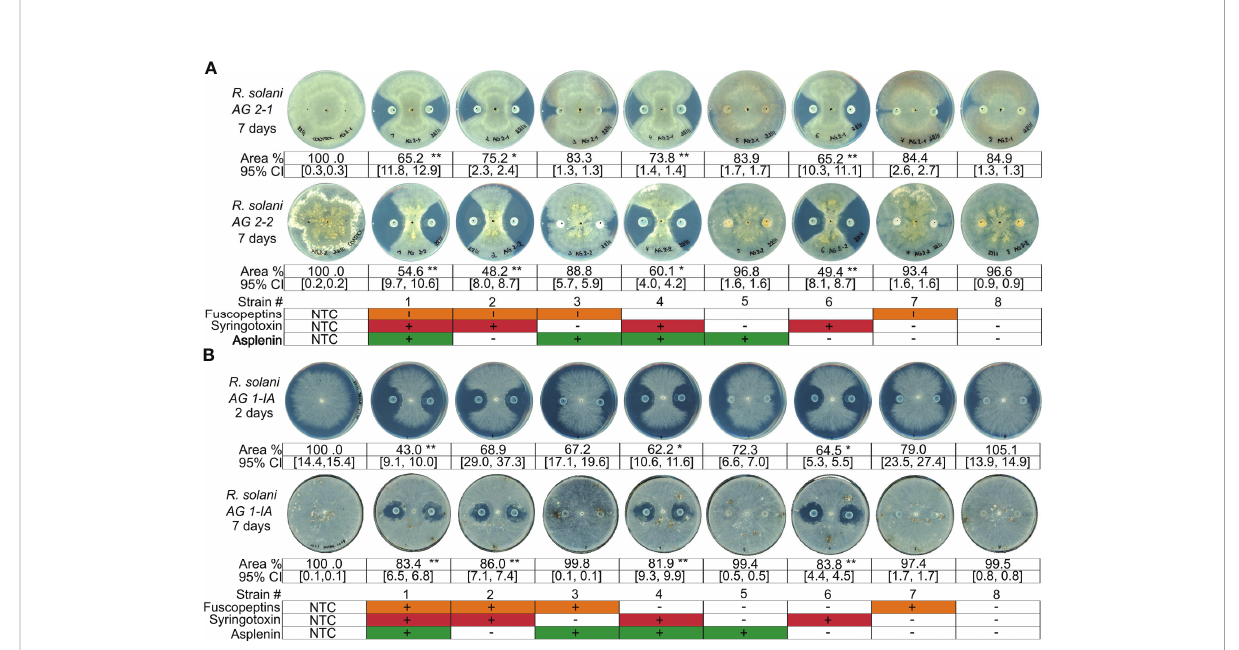
FIGURE 3 Antagonistic activity of P. fuscovaginae UPB0736 and its CLP mutants against Rhizoctonia solani strains. (A) Rhizoctonia solani A2-1 and AG2-2 and challenged with P. fuscovaginae UPB0736 and its CLP mutants. Pictures were captured 7 days post inoculation. (B) Rhizoctonia solani AG 1- IA challenged with P. fuscovaginae UPB0736 and its CLP mutants. Pictures were captured 2 and 7 days post inoculation, to take into account the faster growth rate of the strain. Growth rates of the three R. solani strains are shown in fi gure S8. The experiments were conducted at least twice, in triplicate, with comparable output. Values indicate the mycelial area % compared to NTC (full plate). Con fi dence intervals indicate the 95% con fi dence interval (normal distribution). The table at the bottom of the fi gure refers to the phenotypes of WT and CLP mutants, as indicated in Table 3. NTC, non-treated control. 95% CI: 95% con fi dence interval. Statistical signi fi cance was calculated with Kruskal-Wallis and post hoc pairwise Dunn tests. **: p ≤ 1.00e-02, *: 1.00e-02<p ≤